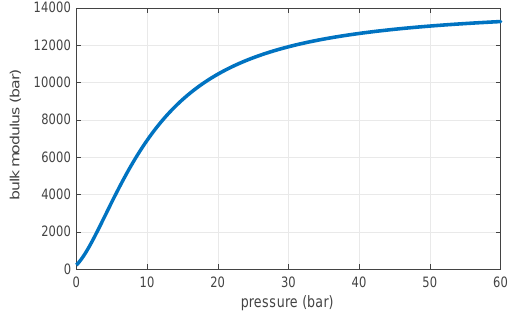
Figure 20. Bulk modulus as function of the pressure.